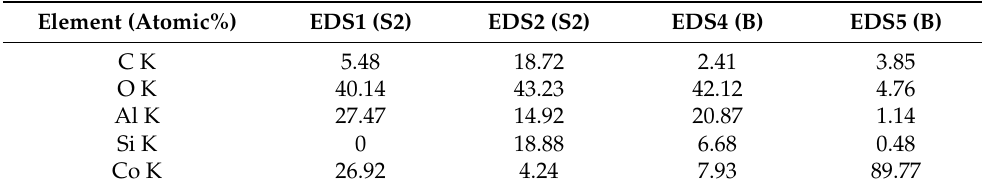
Figure 2. TEM images of catalysts S2 ( a ) and B ( b ). Table 1. Composition of local spots in TEM images in Figure 2. Table 1. Composition of local spots in TEM images in Figure